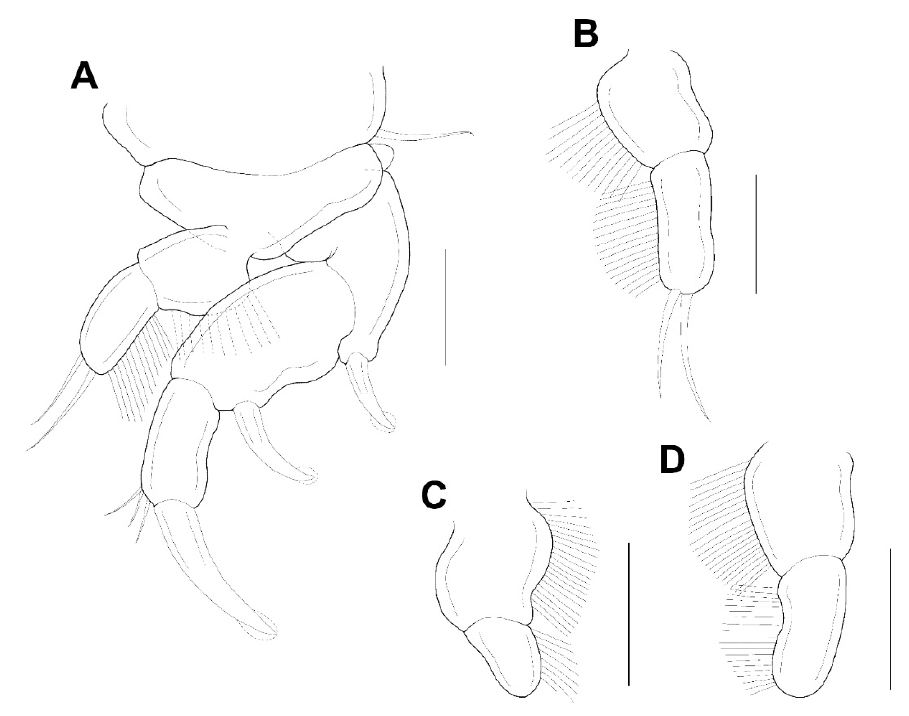
Figure 9. Xarifia magnifica sp. nov. female. Leg 1 ( A ); endopod of leg 2 ( B ); endopod of leg 3 ( C ); endopod of leg 4 ( D ). Scale bars: ( A – D ) = 0.025 mm. Leg 5 (Figure 7A–C) as that in X. yanliaoensis sp. nov., but slightly stout, about 275.5 µm long and 75.5 µm wide at base. Male: Body (Figure 10A,B) slender than female, about 8.2 times longer than wide. Length 1.55 (1.53–1.57) mm and greatest width 0.19 (0.16–0.21) mm based on two speci- mens in lactic acid before dissection. Abdomen (Figure 10A) segmentation indistinct. Cau- dal ramus (Figure 10C) small, about 55.8 × 27.9 µm, ornamented with several setules, bear- ing with 4 terminal setae (lateral seta not clearly evident). Body surface covered with sev- eral setules (Figure 10A,B).